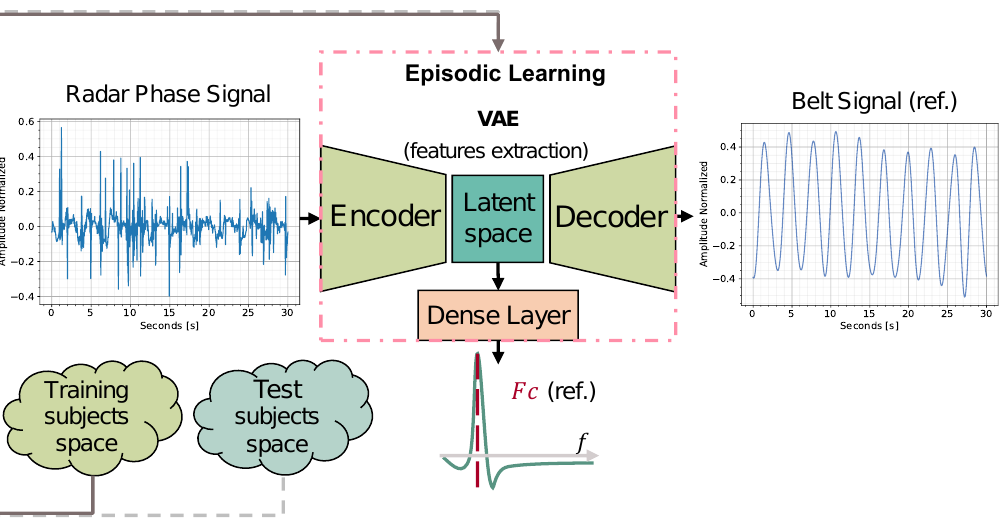
Figure 1. For each learning episode, a training subject is randomly sampled. For each training shot, the radar phase information is mapped to the reference belt signal (ref.) via a C-VAE. Through a dense layer, the ANN also tries to regress the extracted respiration Fc , learning from the ideal belt Fc . The latent space mapping is thus constrained to the Fc , whose estimate is also used in the prediction